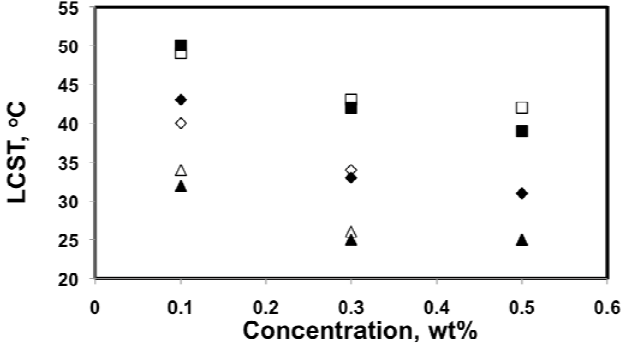
Figure 8. LCST of poly(DMAEMA- stat -styrene) with 96 mol% DMAEMA (DMAEMA/S-95/5, (cid:132) ), 89 mol% DMAEMA (DMAEMA/S-90/10, (cid:139) ), and 84 mol% DMAEMA (DMAEMA/S-85/15, ▲ ), as a function of solution concentration in de-ionized water; filled symbols are DLS results and hollow symbols are UV-Vis